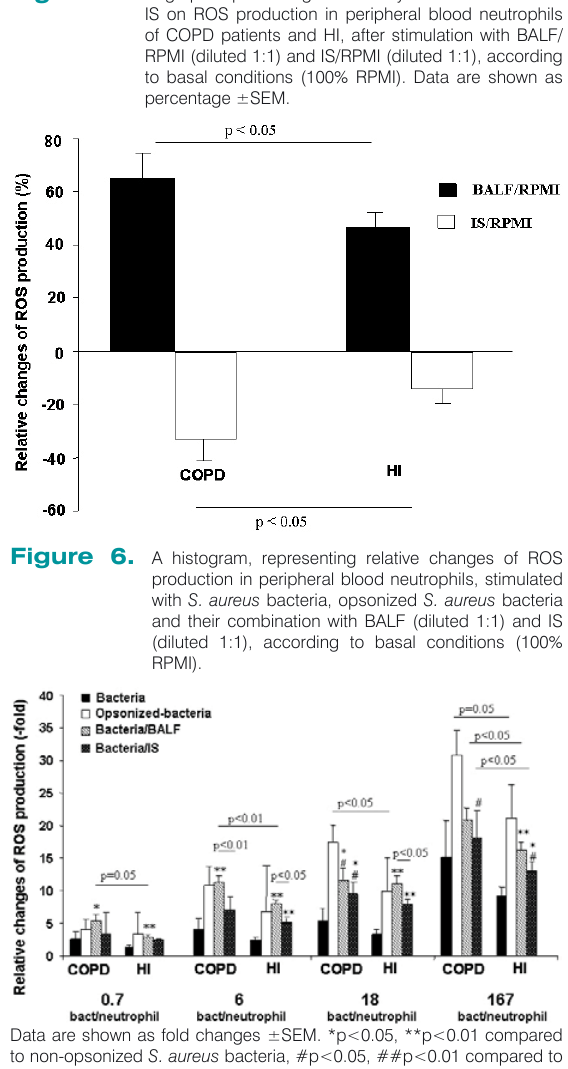
Figure 5. A histogram, representing relative changes of ROS production in peripheral blood neutrophils of COPD patients and HI, after stimulation with BALF in combination with different concentrations of PMA (diluted 1:1), according to basal conditions (100% RPMI).